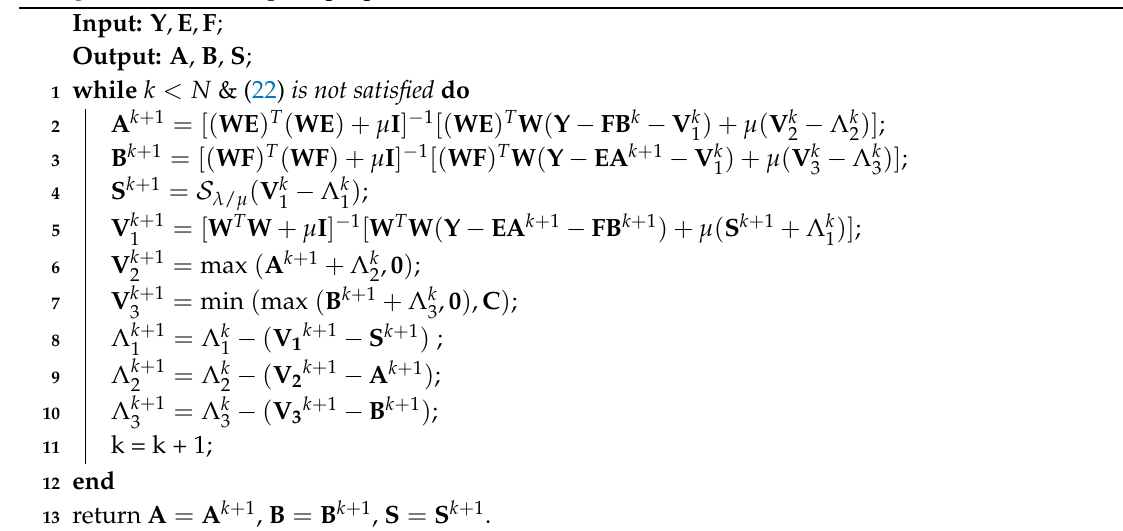
Algorithm 1: Solving the proposed NU-BGBM with